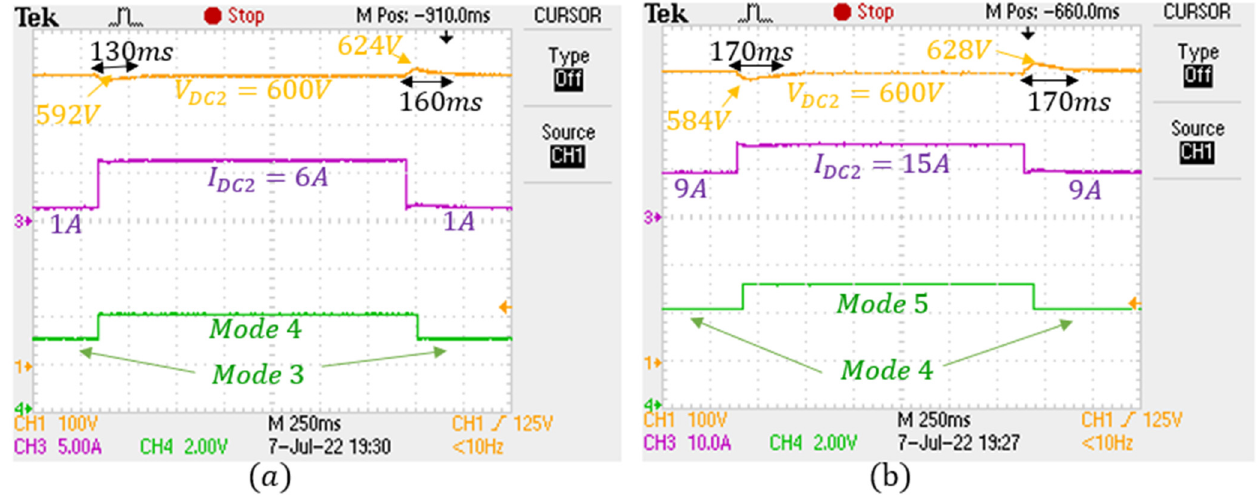
Figure 19. Transient behavior ( a ) mode 3 to mode 4, ( b ) mode 4 to mode 5.